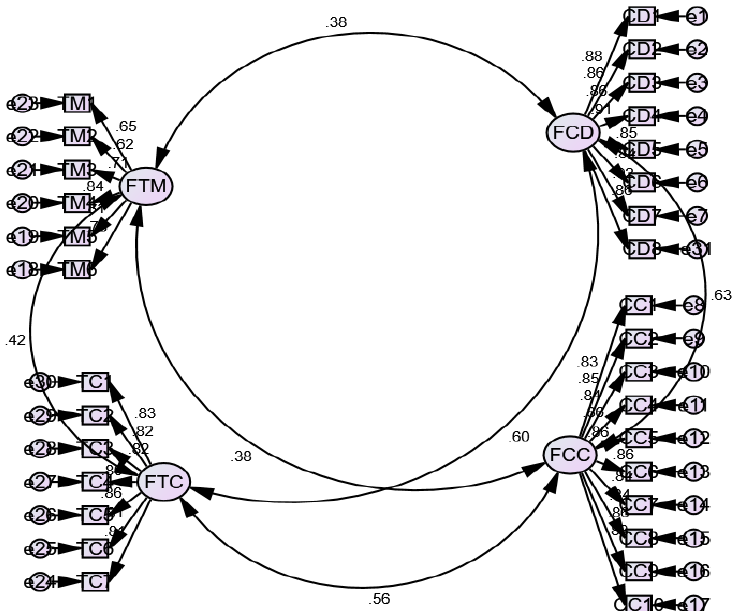
Figure 4. First-order measurement model for teacher-level constructs (four-factor measurement model).